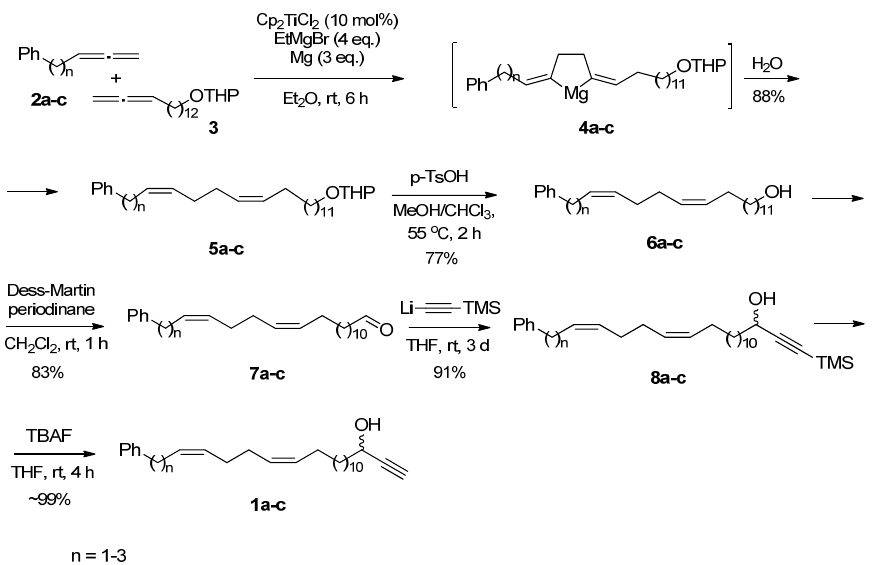
Scheme 1. Synthesis of aromatic derivatives of lembehyne